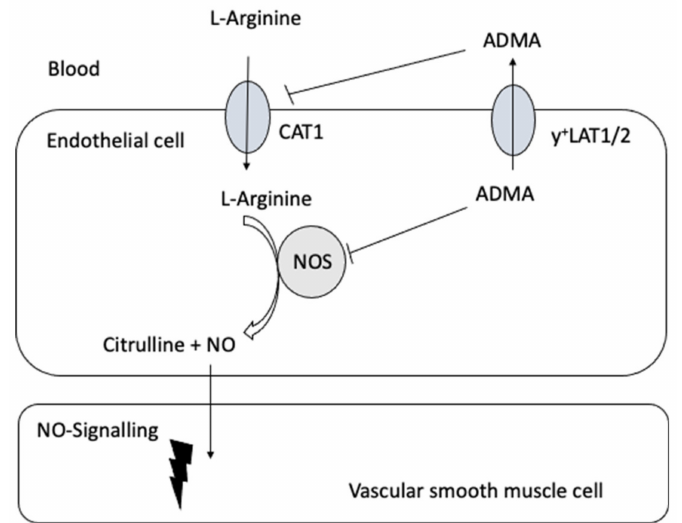
Figure 3. A schematic diagram of the possible interrelation of the transport of L-arginine and its derivatives and nitric oxide (NO) signaling in the